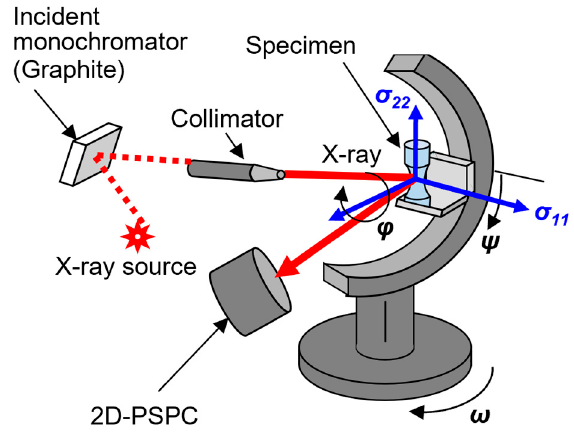
Figure 4. Schematic diagram of XRD system. Table 1. Measuring conditions for 2D method.